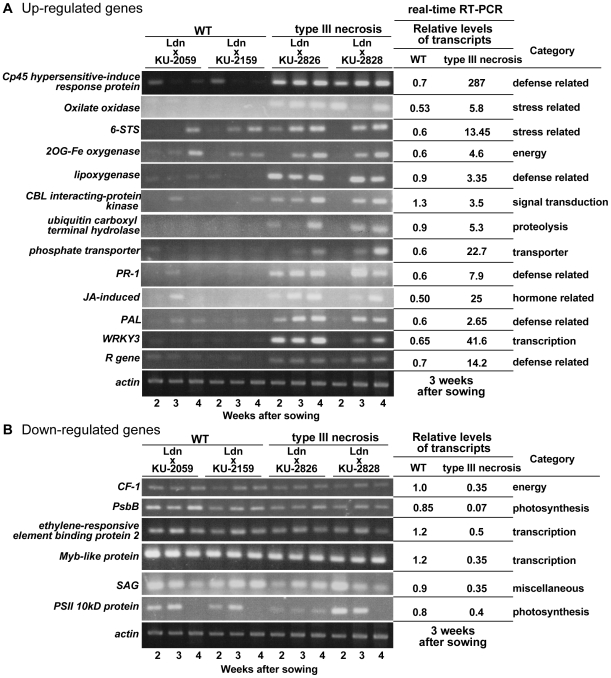
Alteration of transcript accumulation levels in type III necrosis.RT-PCR and real-time RT-PCR analyses were performed using probe-specific primers. Total RNA was extracted from the 1st leaves of 2-, 3- and 4-week-old seedlings. The Actin gene was used as an internal control. Mean of relative transcript levels of the WT and type III necrosis lines revealed by real-time RT-PCR analysis is represented on the right side of the electropherograms. Values were calculated relative to the transcript levels in 3-week-old seedling leaves of the WT line (synthetic wheat of Ldn and KU-2059). A) Expression profiles of up-regulated genes identified by microarray analysis. B) Expression profiles of down-regulated genes identified by microarray analysis.